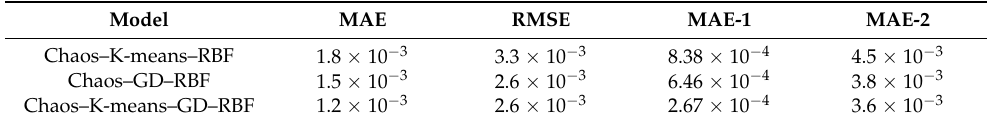
Table 2. Performance comparison of neural network models.